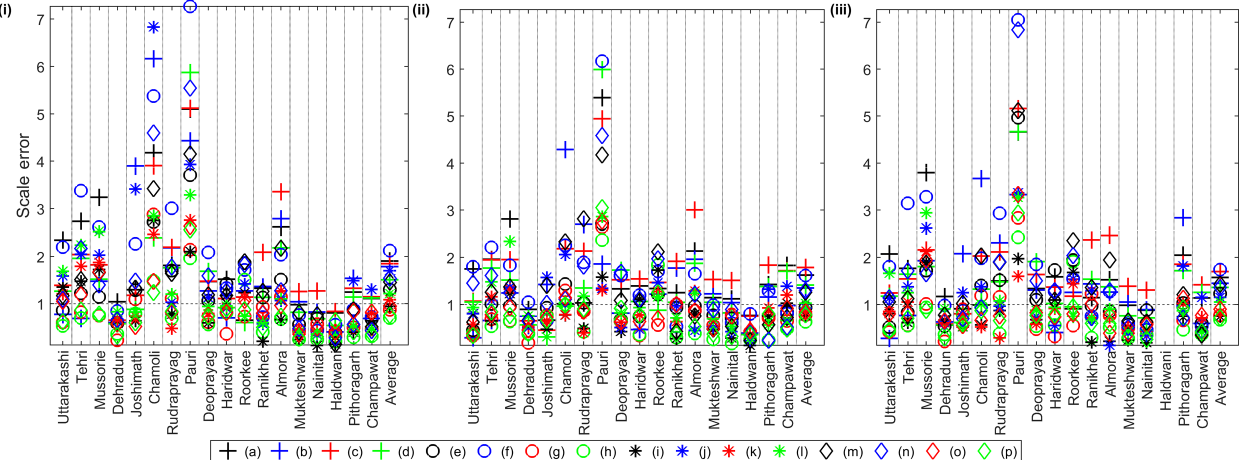
Figure 8. Scale error (SE) in WRF configurations (a) to (p). for 18 locations in the UGB for (i) Domain 1, (ii) Domain 2a and (iii) Domain 2b. Refer to Appendix A (Table A1) for the detailed list of the WRF